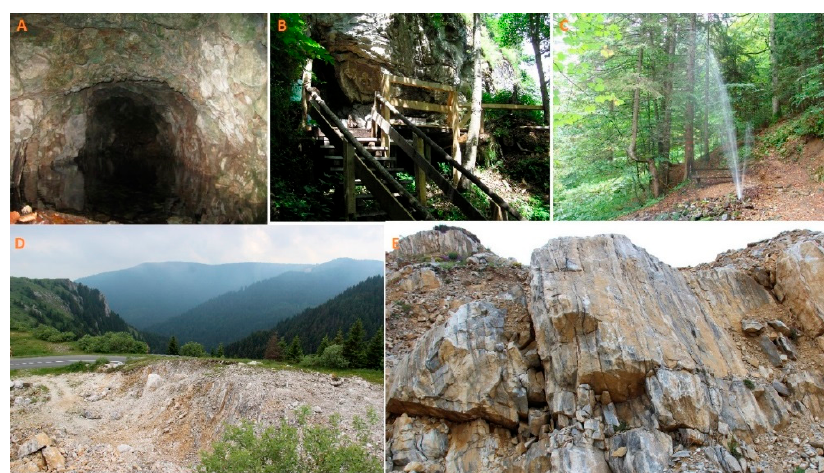
Figure 4. ( A ) Mining shaft; ( B ) cave church “Meto đ e”; ( C ) geyser “Gvozdac”; ( D ) mountain pass “Zavoj”; ( E ) skarns in Jaram.